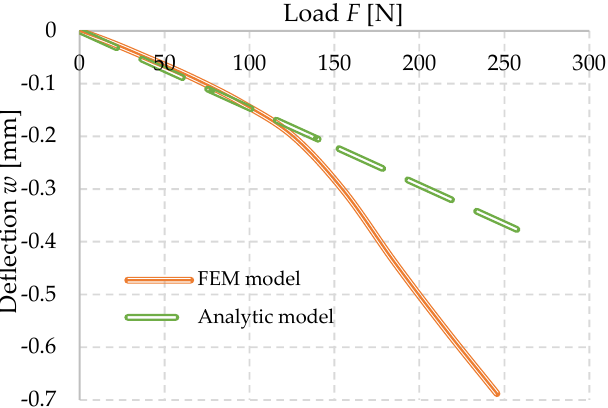
Figure 19. Comparison of theoretical results–dependence of deflection (cantilever end) on force (load of the cantilever end).